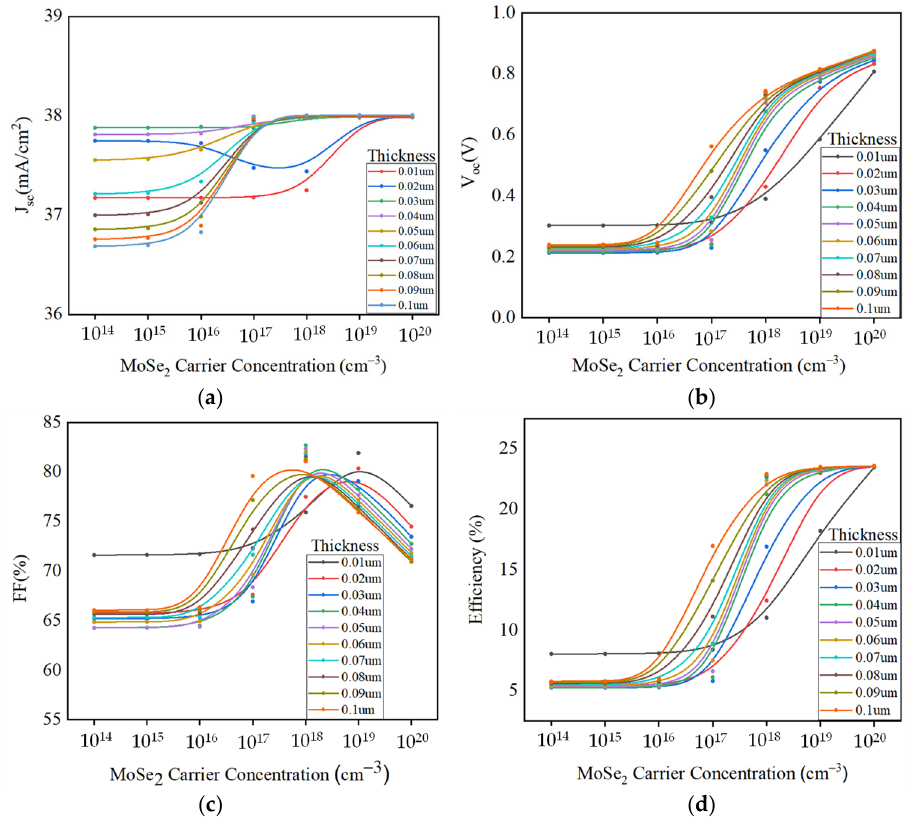
Figure 4. The simulated electrical performance parameters as a function of MoSe 2 acceptor carrier concentration ranging from 1.0 × 10 14 to 1.0 × 10 20 cm − 3 : ( a ) J SC ; ( b ) V OC ; ( c ) FF; and ( d ) conversion efficiency (PCE) at different MoSe 2 layer thicknesses ranging from 0.01 μ m to 0.1 μ m.